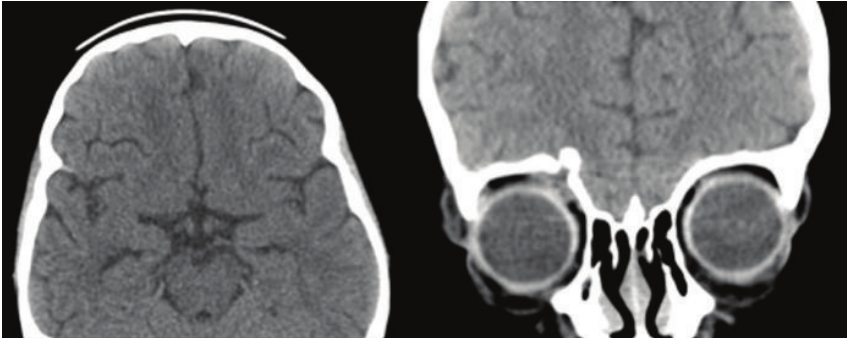
Figure 4: Computed tomography (CT) scans of the cranium demonstrating the resolution of frontal edema and abscess 8 weeks after